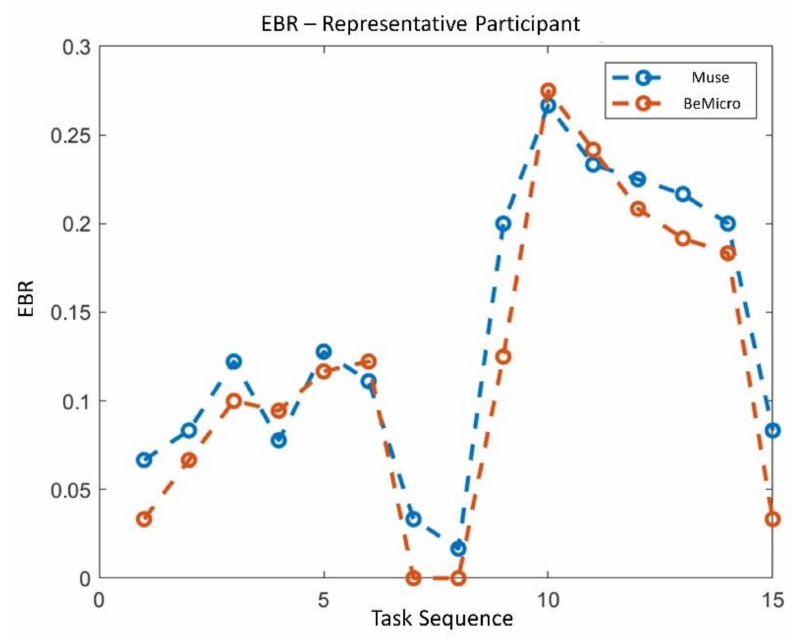
Figure 10. Time dynamics of EBR across all experimental task and conditions for both consumer wearable (blue) and laboratory device